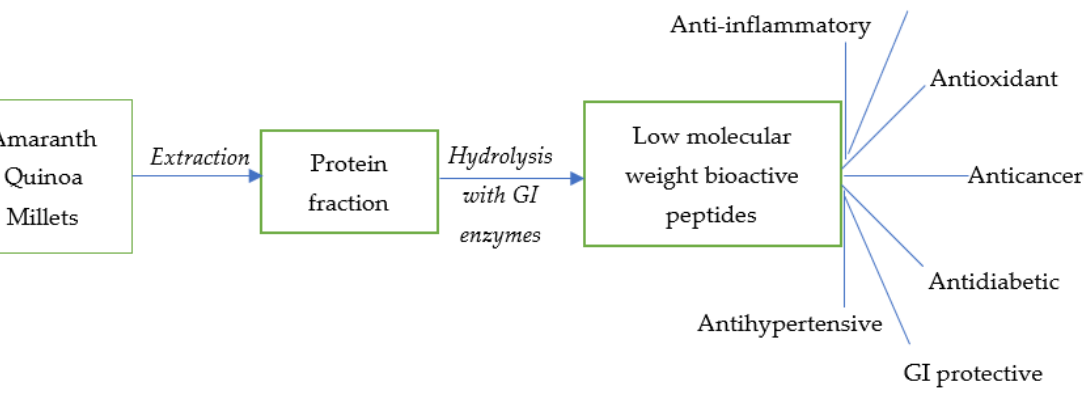
Figure 2. Health benefits of bioactive peptides extracted from amaranth, quinoa, and millet proteins.